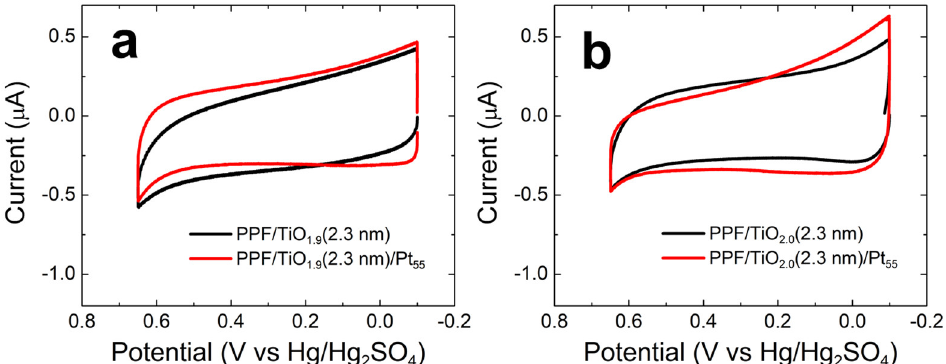
Figure 4. CVs obtained for CO electrooxidation on ( a ) PPF/TiO 1.9 (2.3 nm)/Pt 55 and ( b ) PPF/TiO 2.0 (2.3 nm)/Pt 55 electrodes. The specific electrode configurations are given in the legends. The solutions contained aqueous, CO-saturated 0.10 M HClO 4 . The electrode potential was scanned between –0.10 and 0.65 V at 0.050 V/s. The experiments were carried out in triplicate for each electrode configuration using independently prepared electrodes to ensure